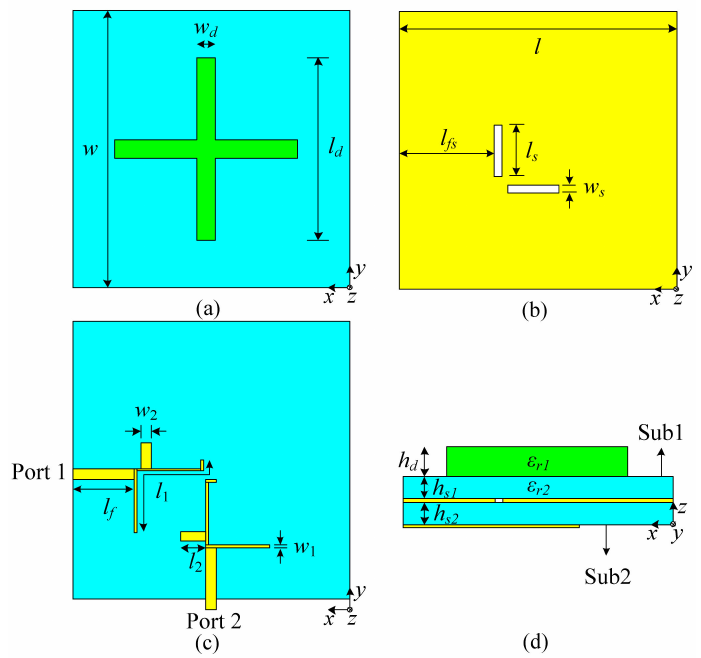
Figure 1. Configuration of the proposed antenna: ( a ) top layer; ( b ) middle layer; ( c ) bottom layer; ( d ) side view.